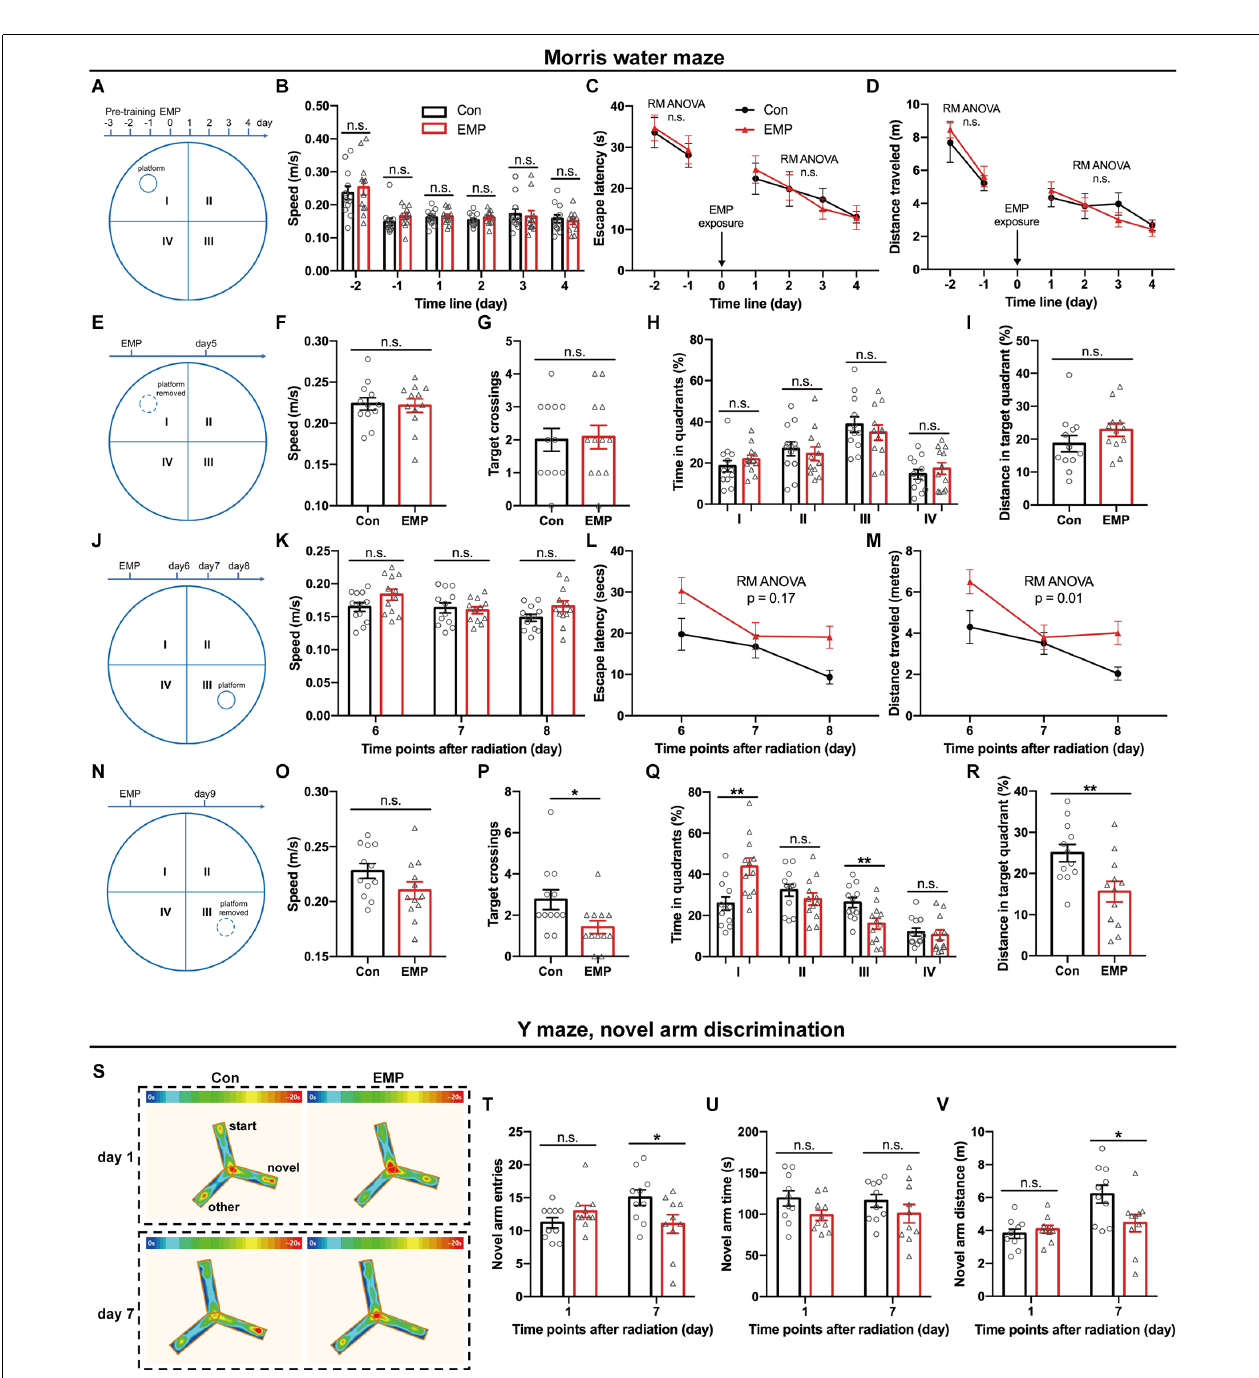
FIGURE 3 | EMPs impair the spatial learning and memory ability in mice. (A–R) Morris water maze (MWM) experiment ( n = 12 mice per group). From day 1 to day 4 post exposure, the platform was placed in the quadrant I and hidden platform tests were conducted, and the speed, escape latency, and distance traveled in locating the platform were analyzed (A–D) . On day 5 post exposure, the platform was removed and probe tests were performed, and the speed, target crossings, time (%) in each quadrant, and distance (%) in the target quadrant (I) were shown (E–I) . From day 6 to day 8 post exposure, the platform was moved to the contralateral quadrant (III), and hidden platform tests were conducted, the speed, escape latency, and distance traveled in locating the platform were presented (J–M) . On day 9 post exposure, the platform was removed, the probe tests were conducted, and the speed, target crossings, time (%) in each quadrant, and distance (%) in the target quadrant (III) were calculated (N–R) . (S–V) Y maze, novel arm discrimination ( n = 10 mice per group). The average heat map of movement was calculated (S), and the novel arm entries, time and distance were analyzed (T–V) . Con, the control group; EMP, the 300 kV/m EMP-exposed group. All data are presented as mean ± SEM. Student’s t -test was used to compare the two groups (B–V) . Repeated-measures analysis of variance (RM ANOVA) was used to evaluate the difference between the two curves in (C,D) and (L,M) . * p < 0.05; ** p < 0.01; n.s., not significant.